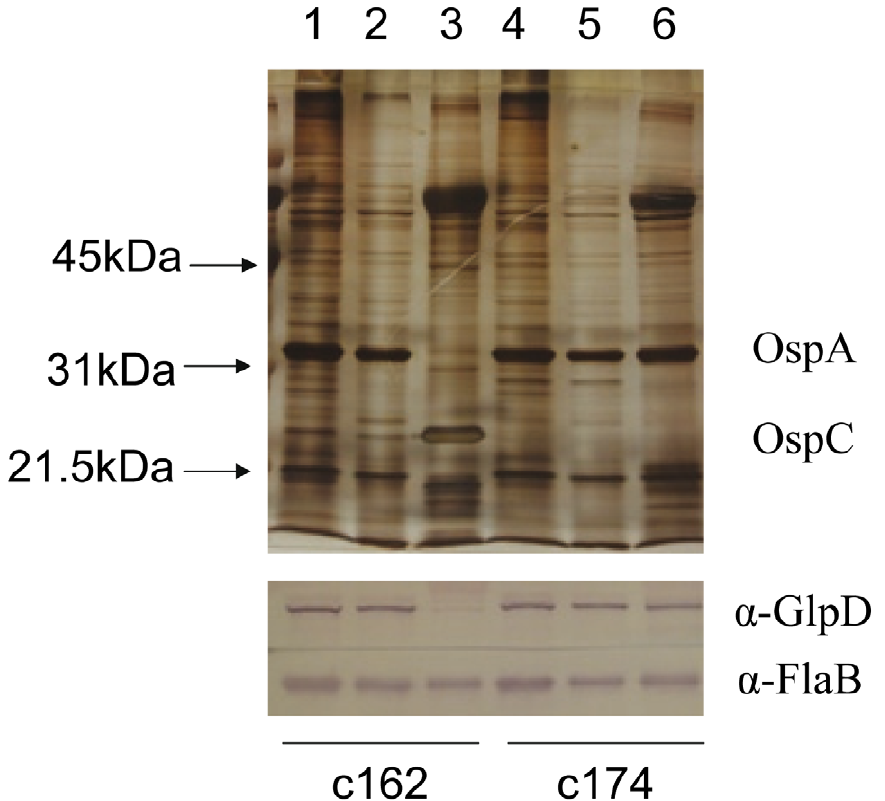
Figure 6. Repression of GlpD expression requires RpoS. Wild type (c162) and RpoS mutant (c174) B. burgdorferi were cultivated in vitro at either 23 u C or 37 u C or in DMC. Cell lysates were subjected to SDS-PAGE and gels were either silver stained (top panel) or blotted to PVDF membranes and developed with antibodies to GlpD or FlaB (bottom panel). Lanes 1 and 4, 23 u C; lanes 2 and 5, 37 u C; lanes 3 and 6, DMC. Migration positions of protein molecular mass markers are indicated on left in top